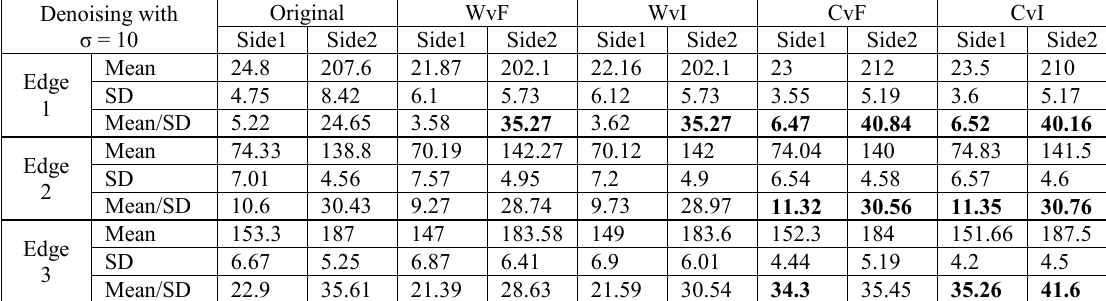
Table 3: Edge preservation capability for Quickbird image (σ = 10)